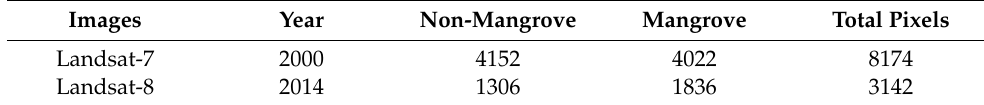
Table 4. Total training pixels for Landsat-7 and Landsat-8.